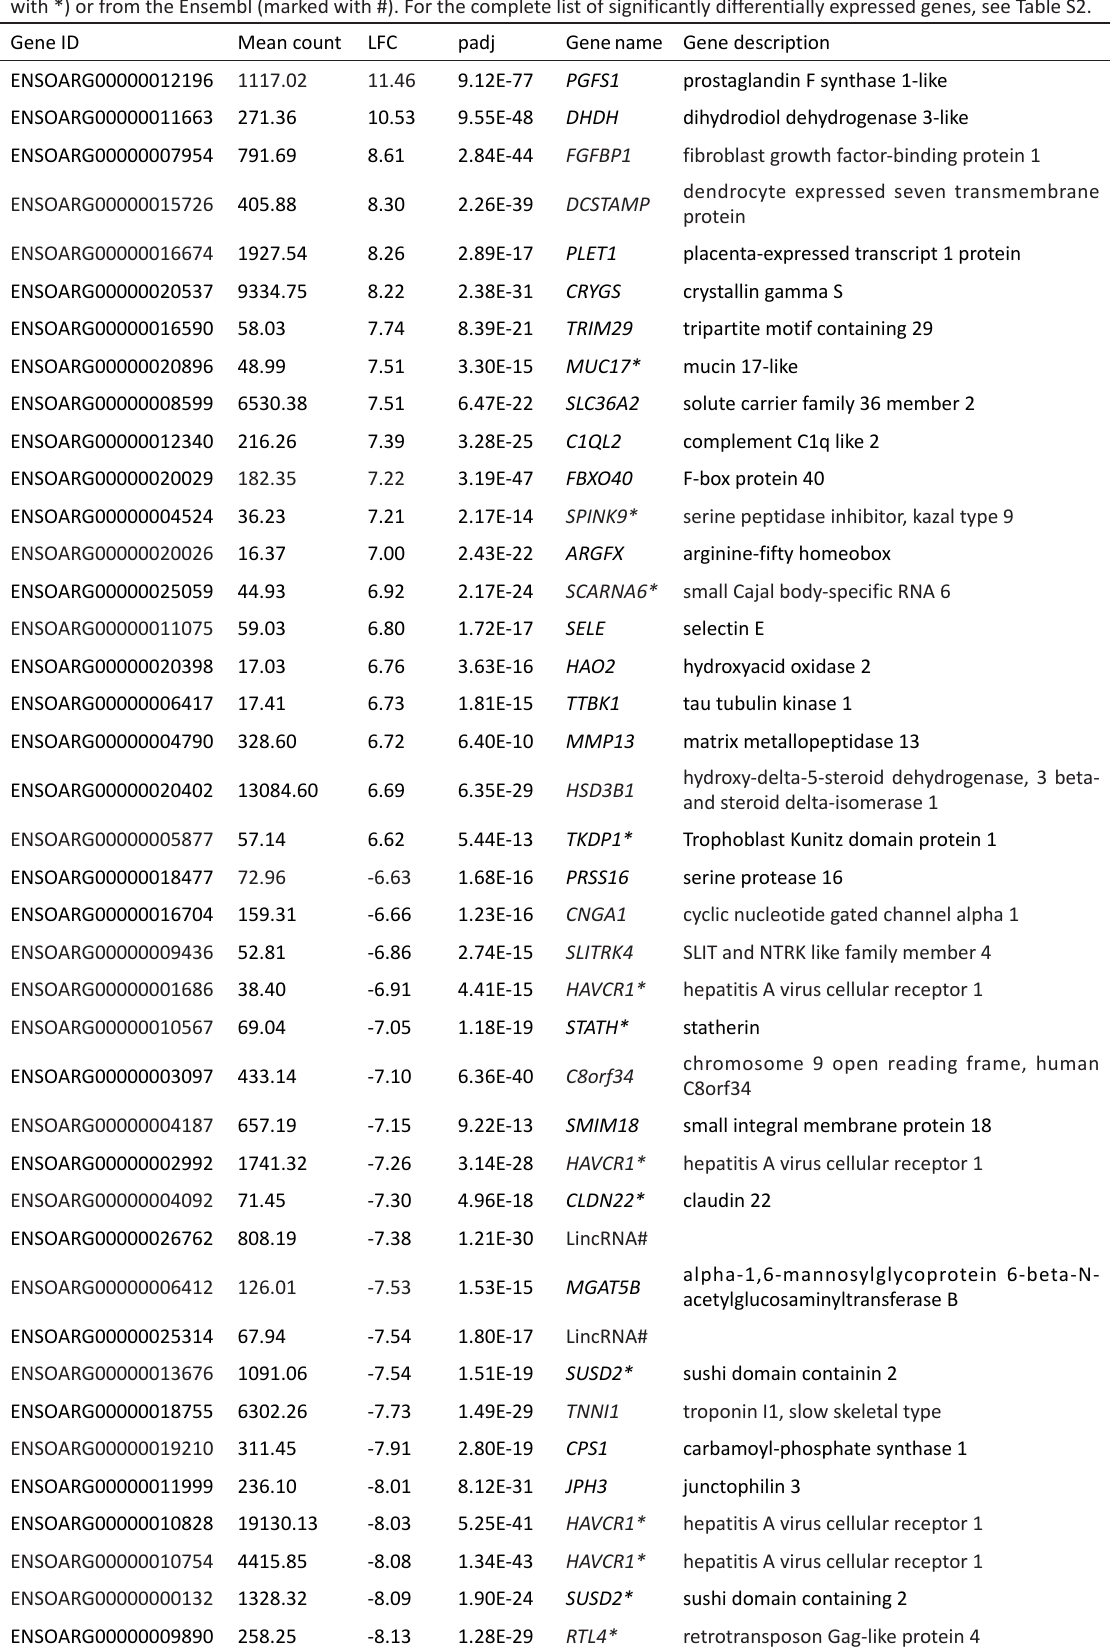
Table 3. Top 40 significantly differentially expressed genes between the endometrium having spherical (S; Day 7 to Day 12) and elongated (E; Day 13 to Day 16) embryos in sheep. The genes were ranked based on the log2 fold change (LFC) values. First 20 genes (with positive LFC values) were the top upregulated genes in E and the rest (bottom 20 with negative LFC) were upregulated in S. Few genes lacking annotations were derived from homology based BLAST search against the non-redundant (NR) database (marked with *) or from the Ensembl (marked with #). For the complete list of significantly differentially expressed genes, see Table S2. Gene ID Mean